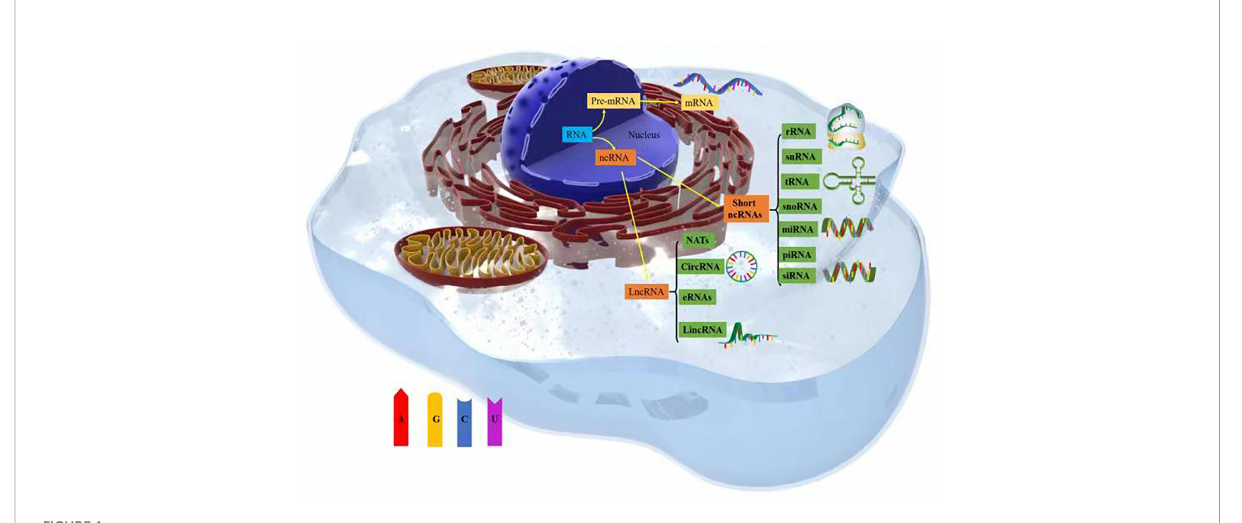
FIGURE 1 Types of noncoding RNAs (ncRNAs).